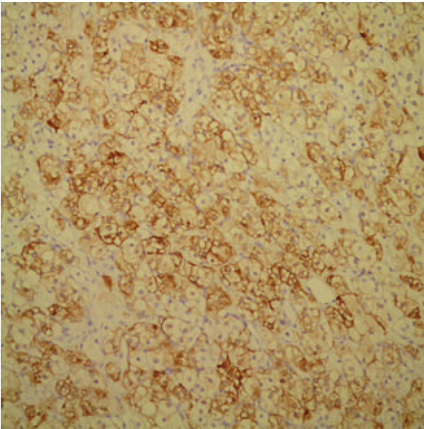
Figure 3: Diffuse membranous positivity with inhibin immunos- taining.